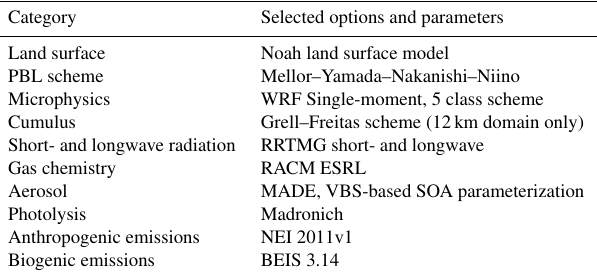
Table 1. Settings and parameterizations used for the WRF-Chem